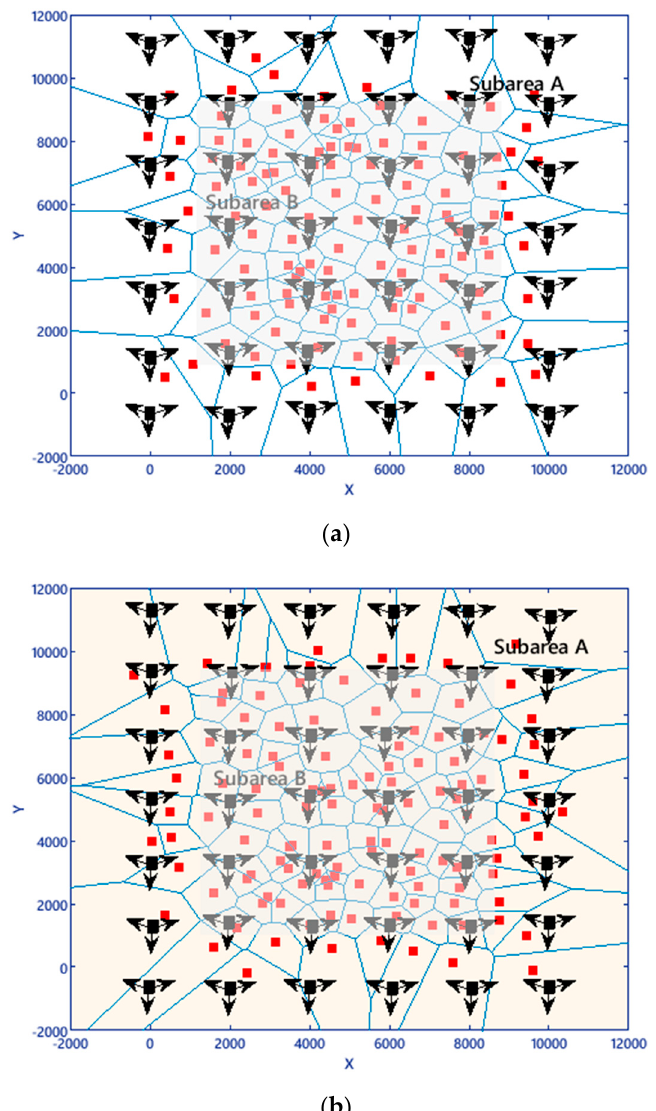
Figure 5. Comparison between PSO and SA in 5G planning at 28 GHz with overlay deployment architecture. ( a ) and ( b ) represent the results for PSO and SA, respectively. Urban macro-cells (Uma) are represented by black squares, whereas UMi are represented by red squares; BSs sector represented by an arrow .